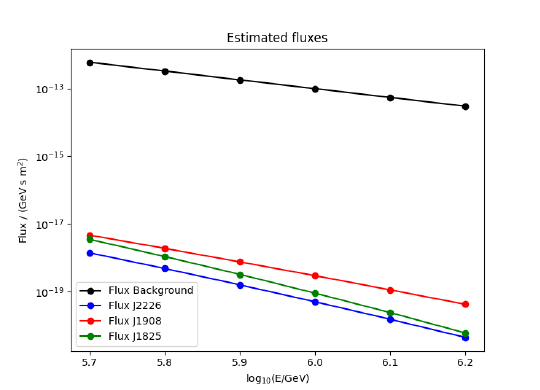
Figure 1: The extended flux of the 3 LHAASO sources [4] up to 2 PeV (colored lines), compared with the background (black line) is shown, an energy range 5.7 < log 10 (E / GeV) < 6.3 and a 4 degree angular resolution for PeV photons at IceCube as circular region in the